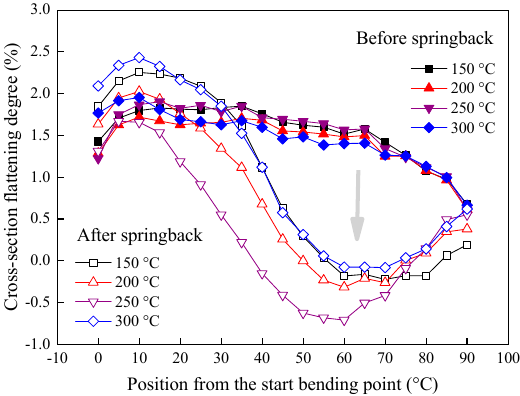
Figure 10. Cross-section flatting degrees under different temperatures.